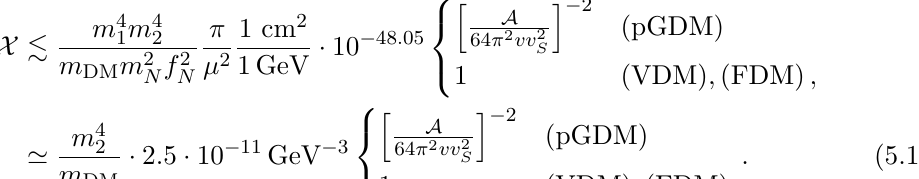
JHEP08(2020)052 ), see eq. (5.6)), 0